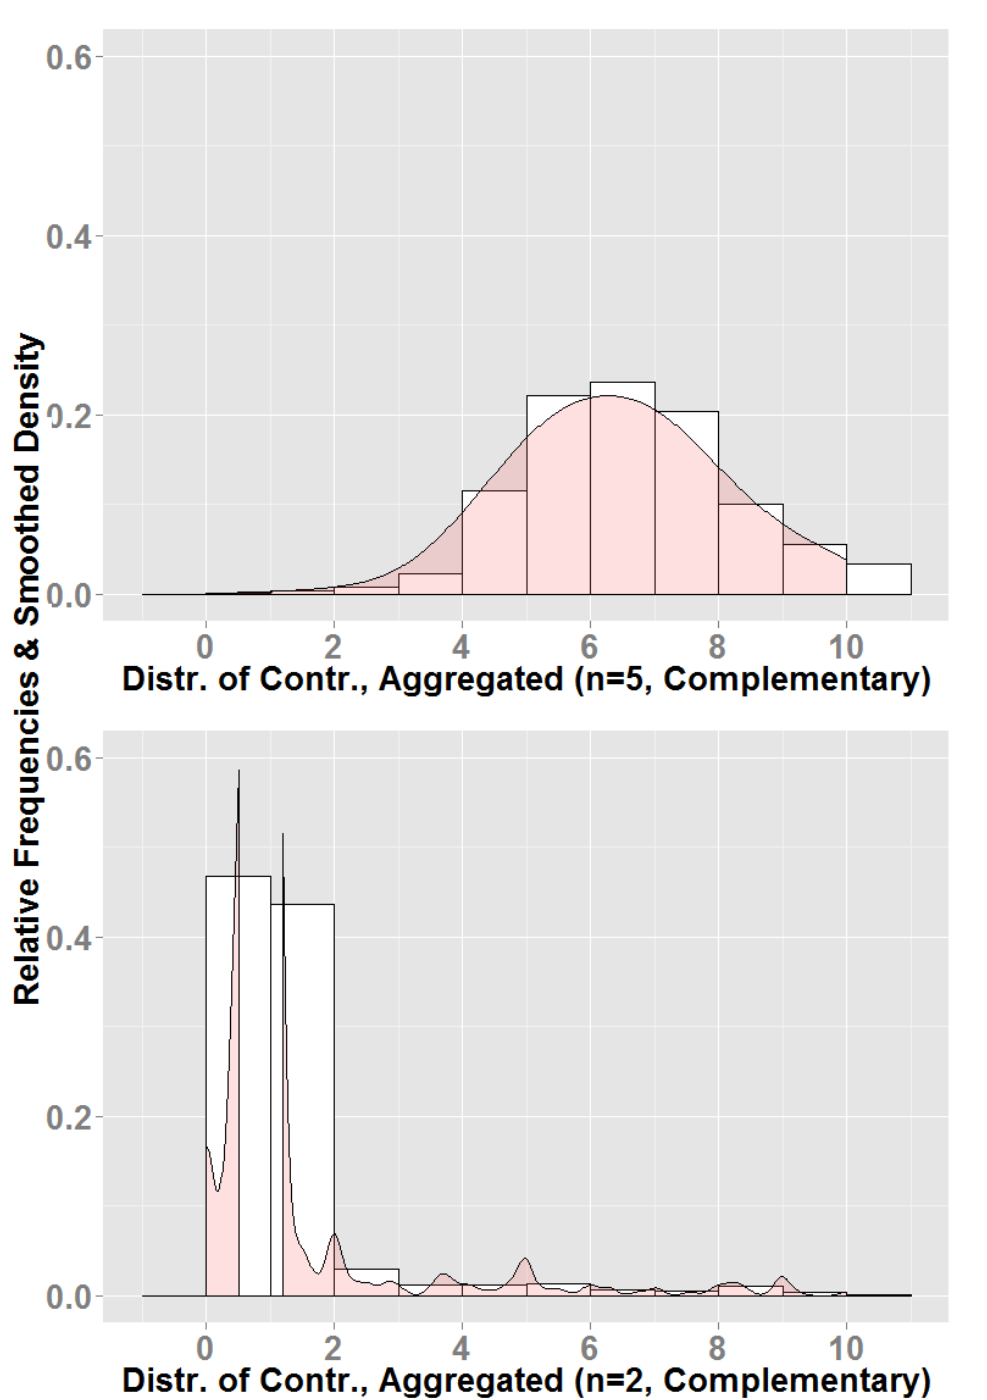
Figure 6. Distribution of the average contribution, SCF with complementarities; upper panel: n = 5, lower panel: n =